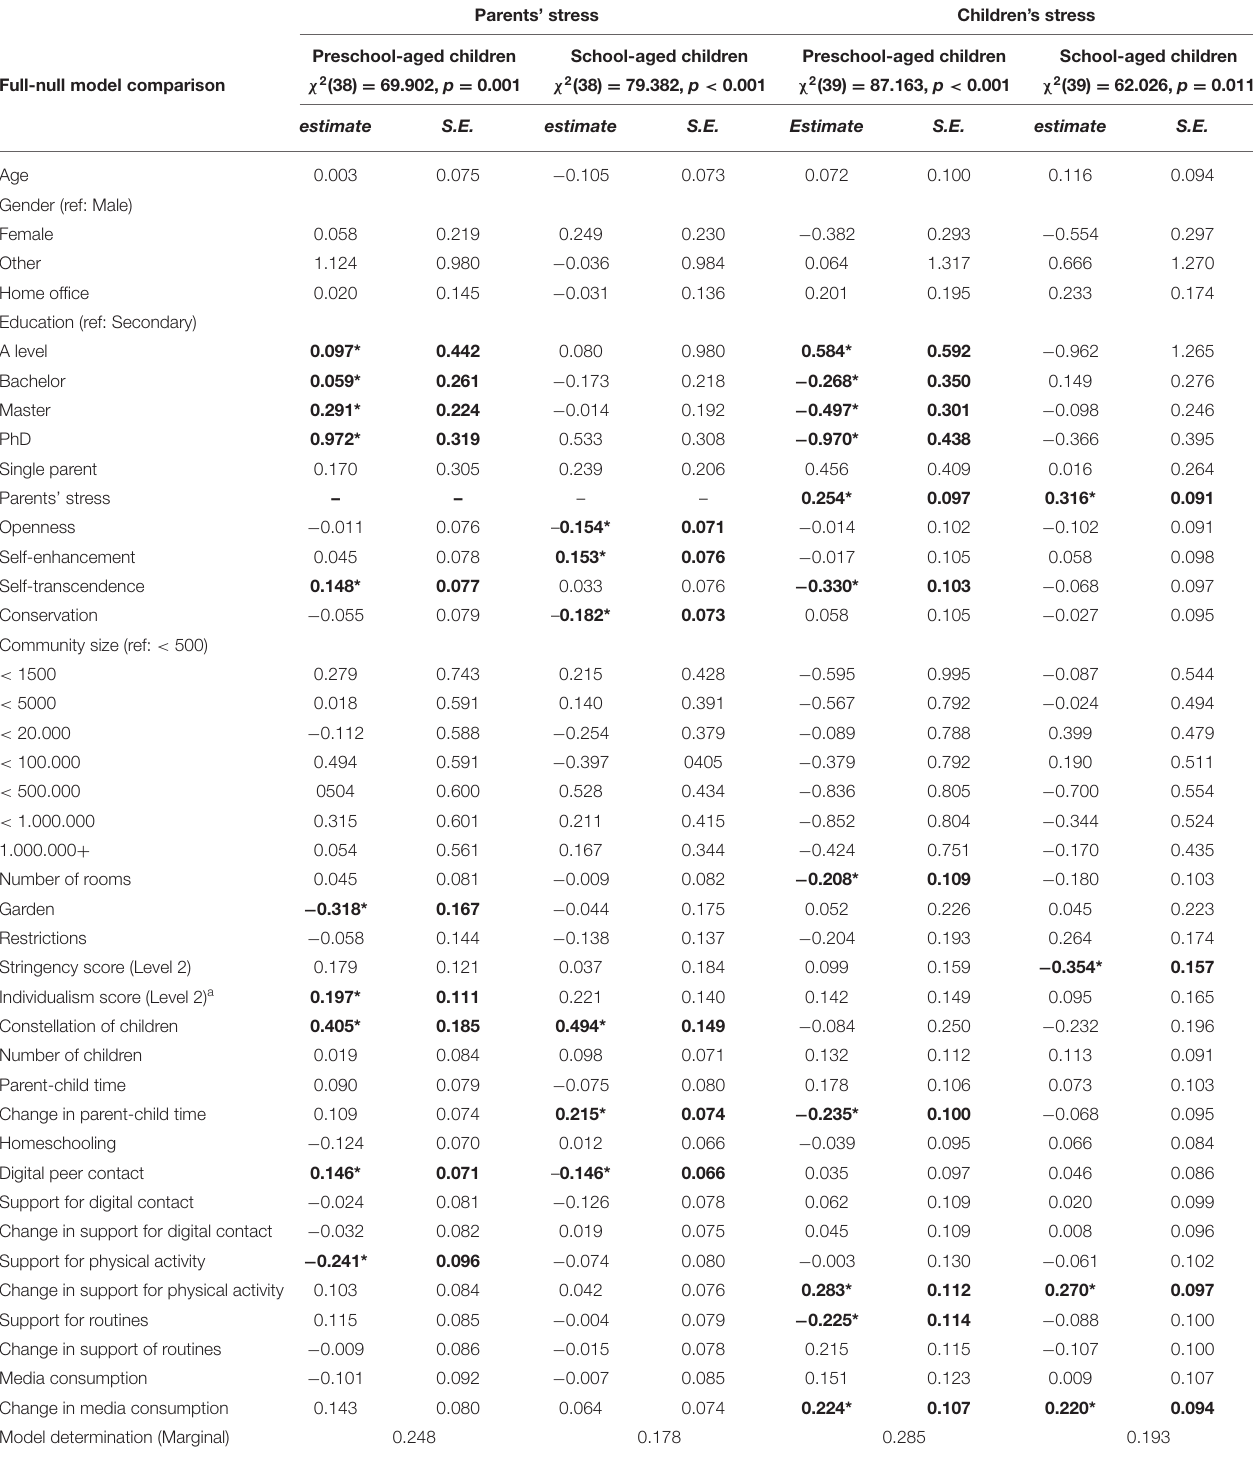
TABLE 2 | Outcomes for inferential